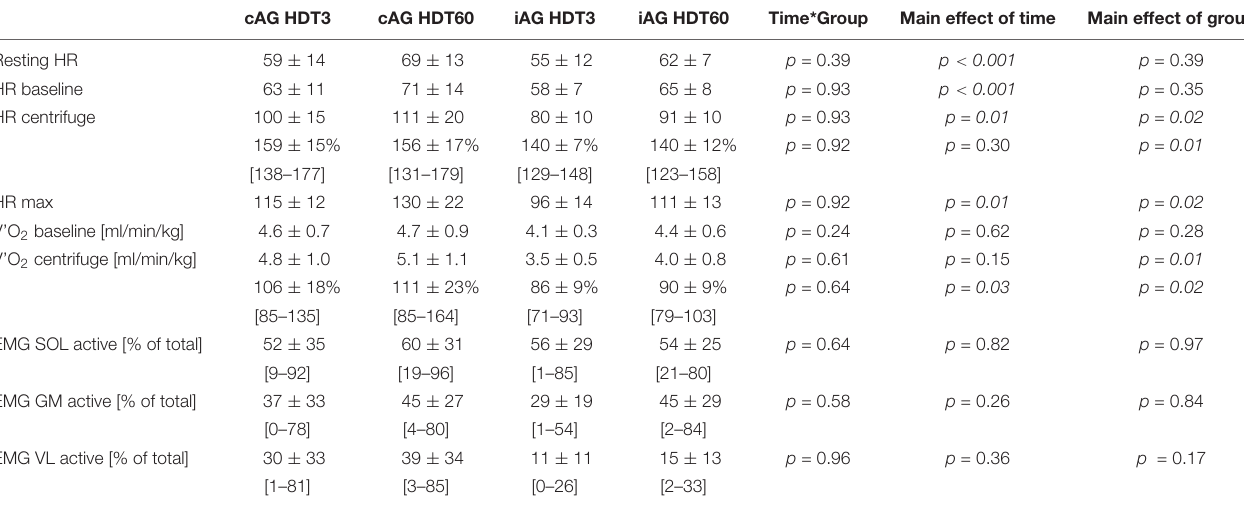
TABLE 1 | Means and standard deviations of heart rate (HR), oxygen uptake (V’O 2 ) and muscle activity (EMG) for the two intervention groups (cAG and iAG) during the artificial gravity sessions on the third (HDT3) and last (HDT60) day of head-down tilt bed rest. cAG HDT3 cAG HDT60 iAG